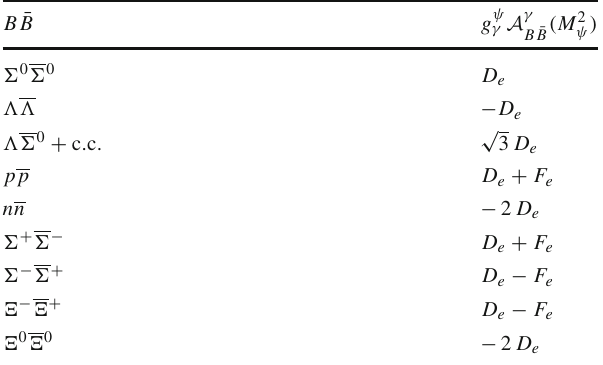
Table 1 Parameterizations of the amplitudes of the EM decay ψ → γ ∗ → B ¯ B as function of the couplings D B ¯ B g